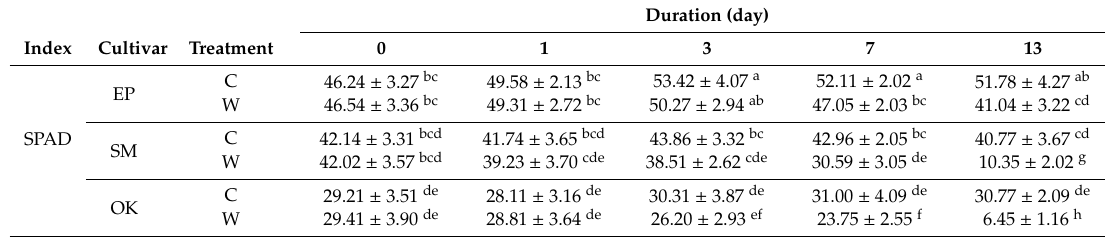
Table 2. E ff ects of waterlogging on soil and plant analysis development (SPAD) chlorophyll meter value in EP, SM, and OK squash plants. Plants were grown under optimally irrigated (control, C) or waterlogging (W) conditions for di ff erent time